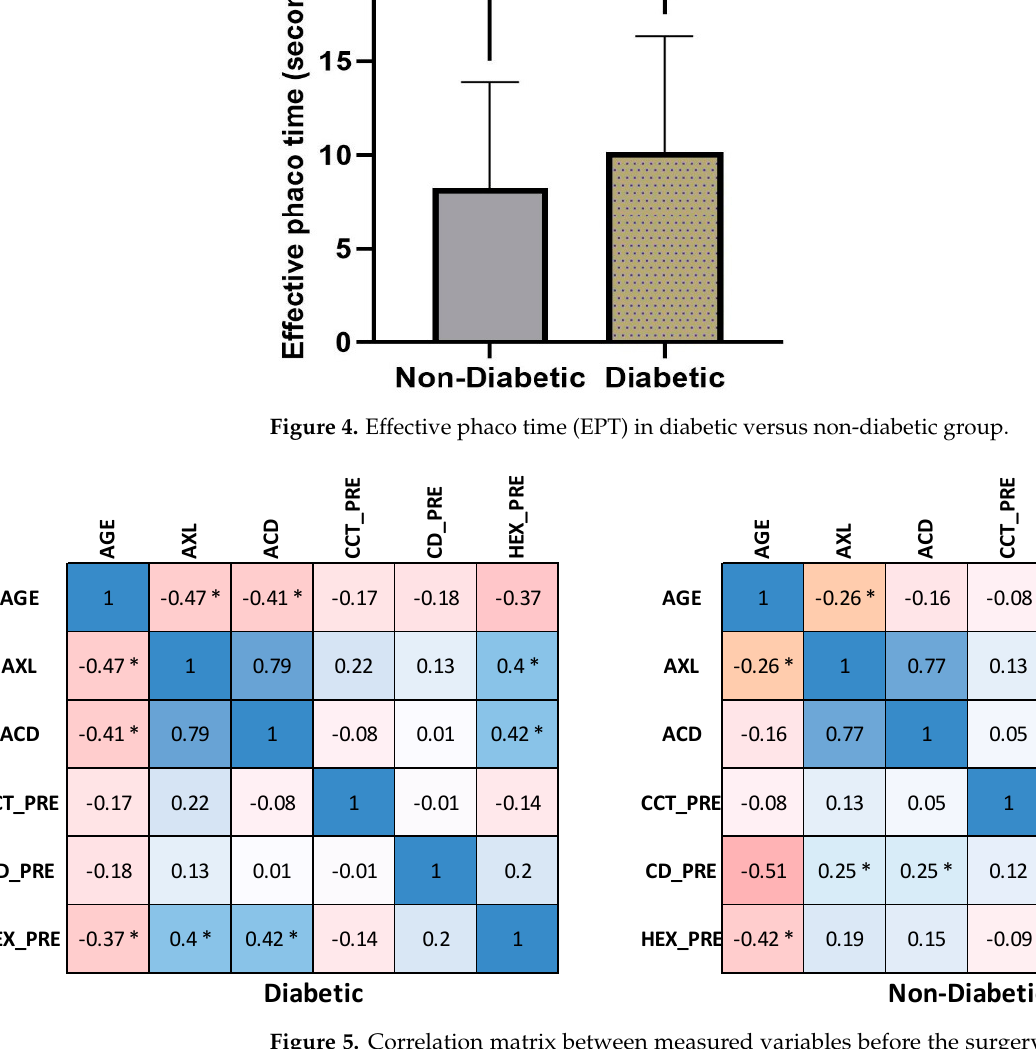
Figure 4. Effective phaco time (EPT) in diabetic versus non-diabetic group.